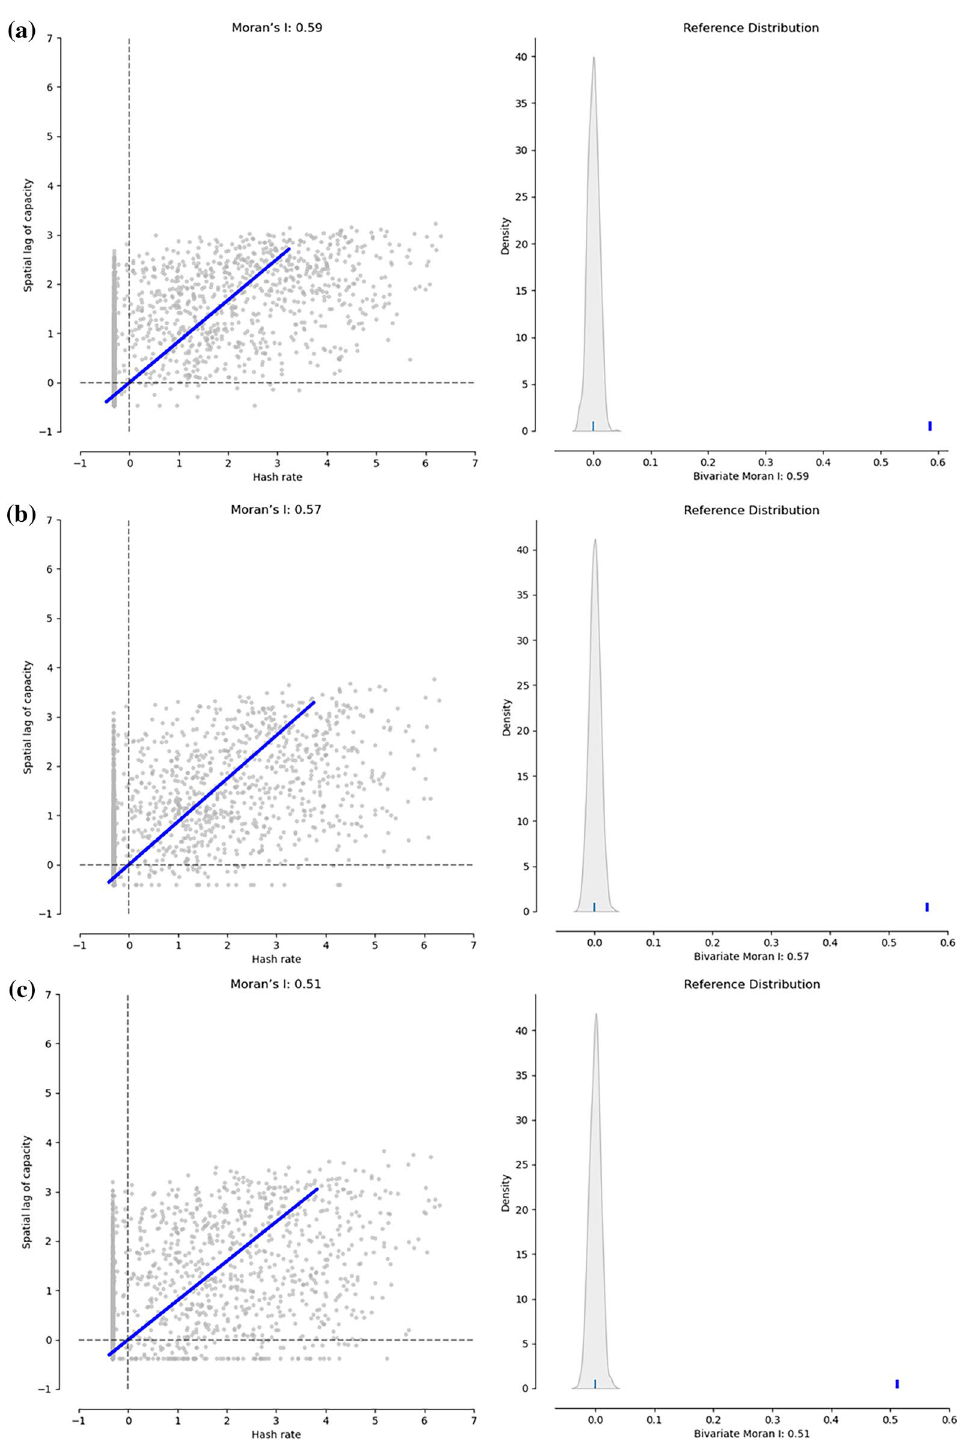
Figure 4. Bivariate Moran’s scatter plots and reference distributions between hash rate and different energy variables. ( a – c ) Bivariate Moran’s statistical results between the hash rate and capacity of all types of energy ( a ), fossil energy ( b ), and renewable energy ( c ) demonstrate the degree of spatial association between them. The scatter plot is depicted with the spatially lagged energy capacity on the y-axis and the original hash rate on the x-axis. The slope of the linear fit to the scatter plot equals Moran’s I. The reference distribution demonstrates the result by randomly permuting the observed values over the locations, which is depicted as a distribution curve in the left. The short line shows the value of Moran’s I, well to the right of the reference distribution. Details of the statistics are supplied in “Methods” and the repository as